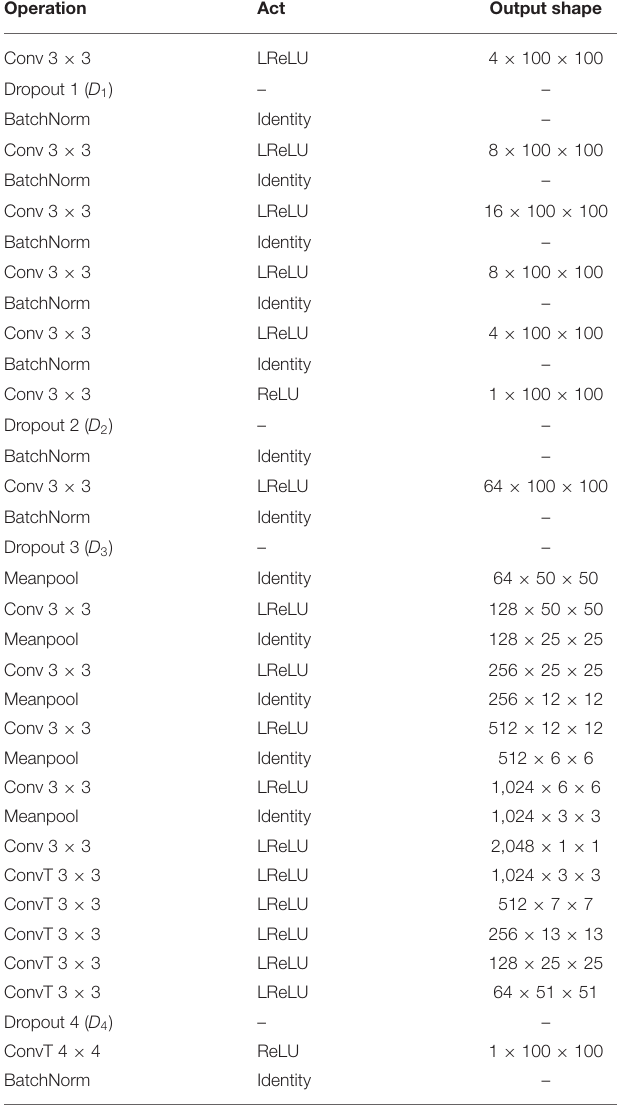
TABLE 1 | Convolutional neural network